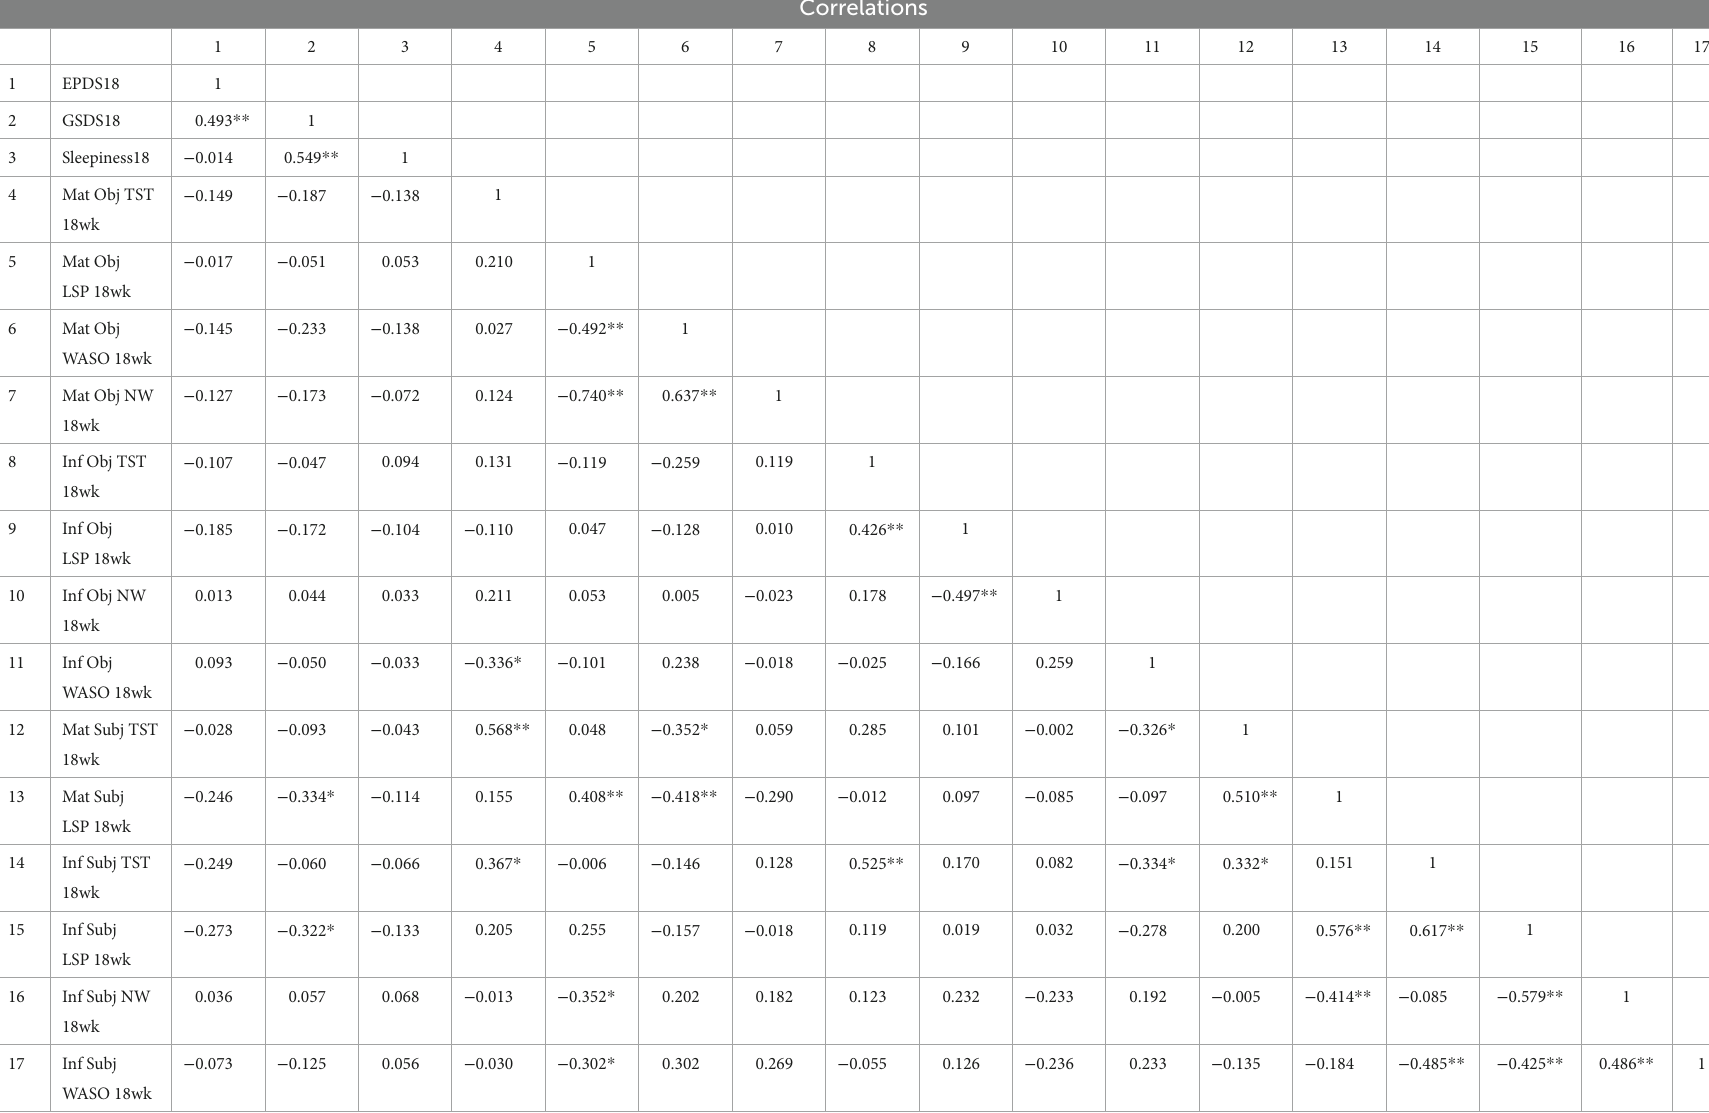
TABLE 5 Bivariate correlations between sleep measures, self-report measures, and EPDS at 18 weeks.